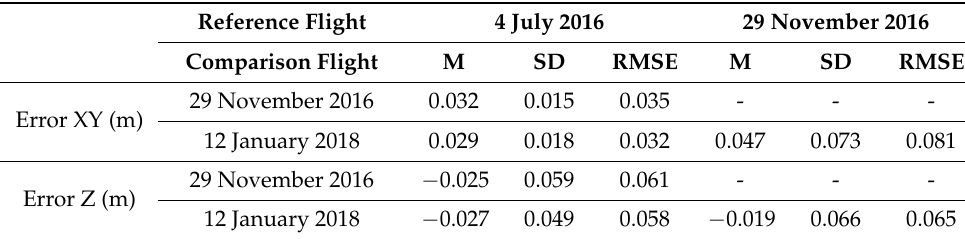
Table 7. Summary of errors between flights in the Colinas Lojanas study area. Displacements calculated between checkpoints in stable